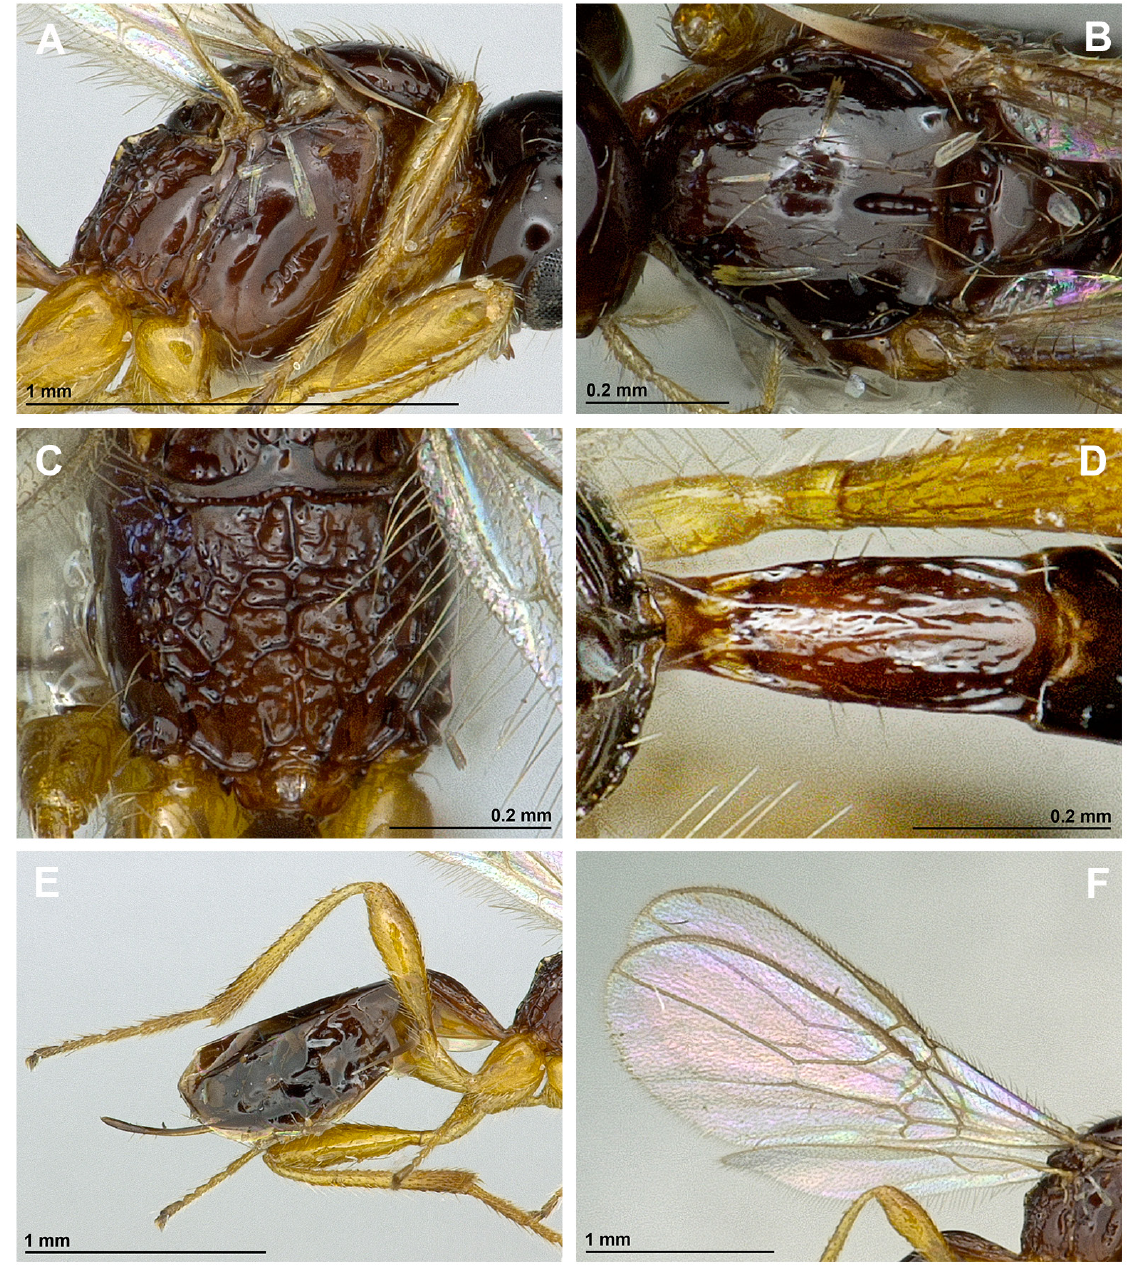
Fig. 5. Synaldis fritzi Peris-Felipo, sp. nov., ♀. A . Mesosoma, lateral view. B . Mesonotum, dorsal view. C . Propodeum. D . First metasomal tergite. E . Legs, metasoma and ovipositor, lateral view. F . Fore and